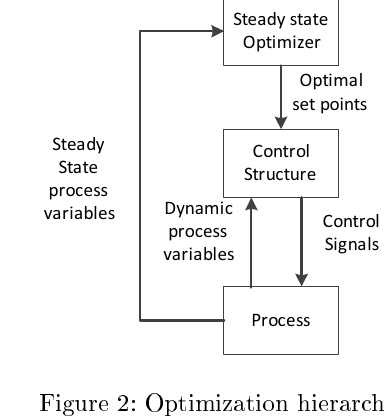
Figure 2: Optimization